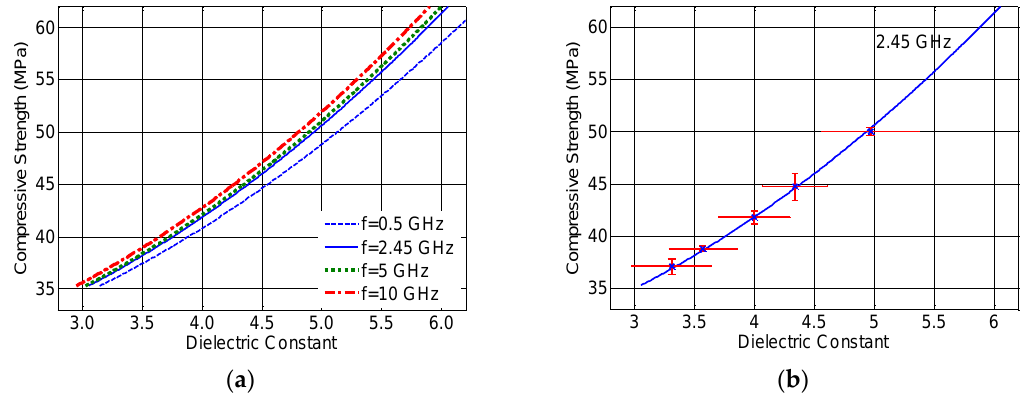
Figure 8. Compressive strength versus dielectric constant of GB concrete, ( a ) at various frequencies; ( b ) at 2.45 GHz with both the standard deviations from measurement.